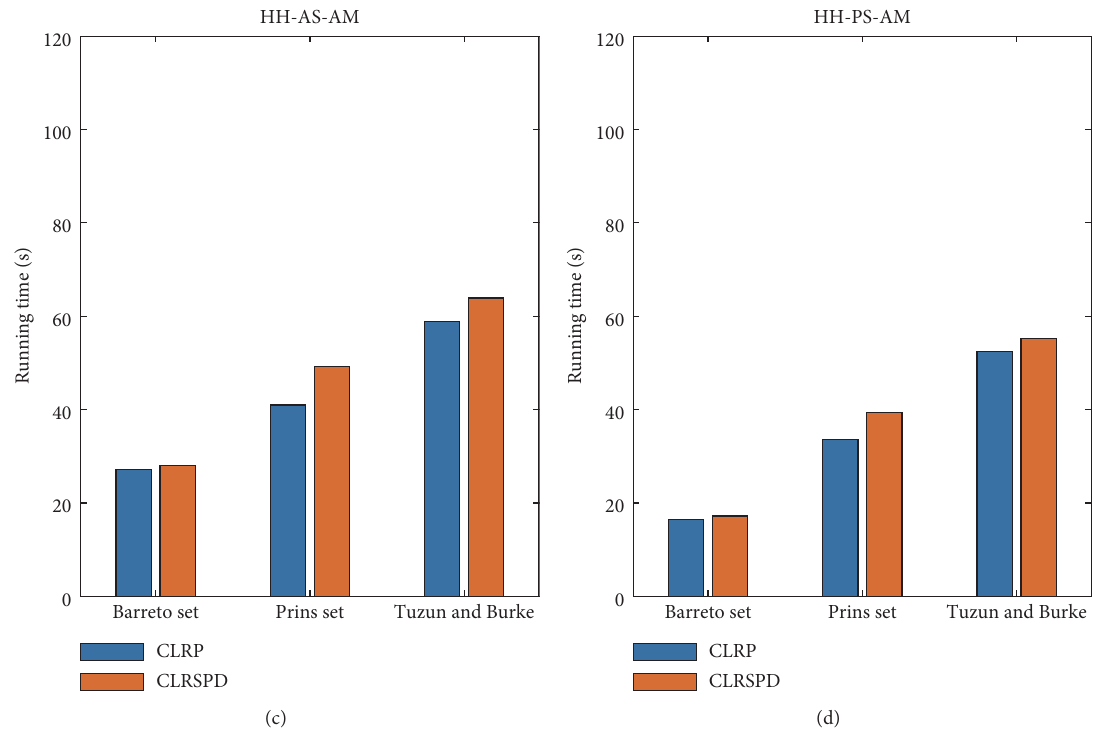
Figure 6: Histogram of computing times of both